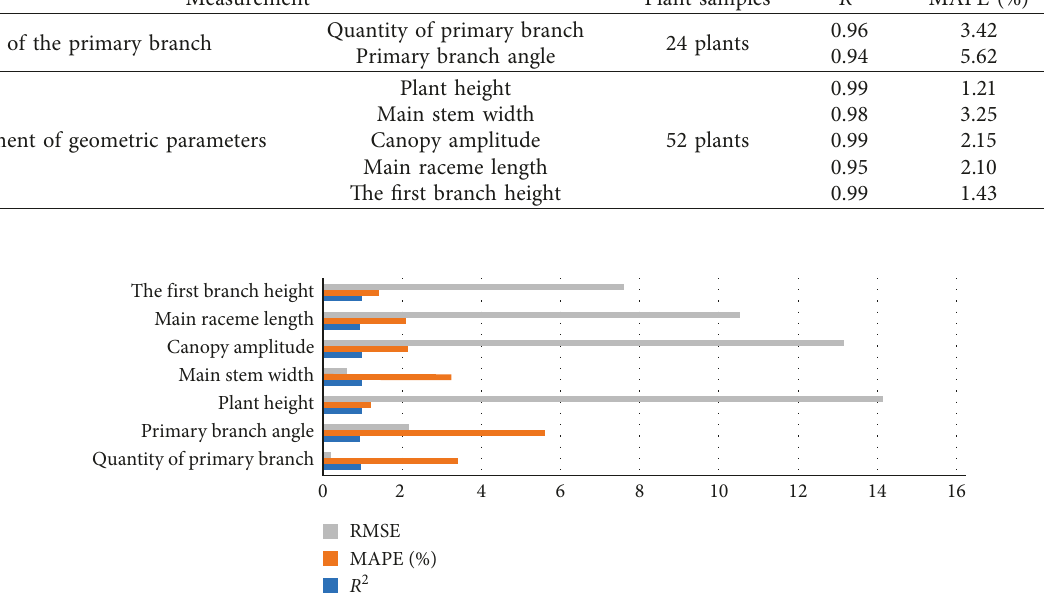
Figure 8: A graphical representation of the test